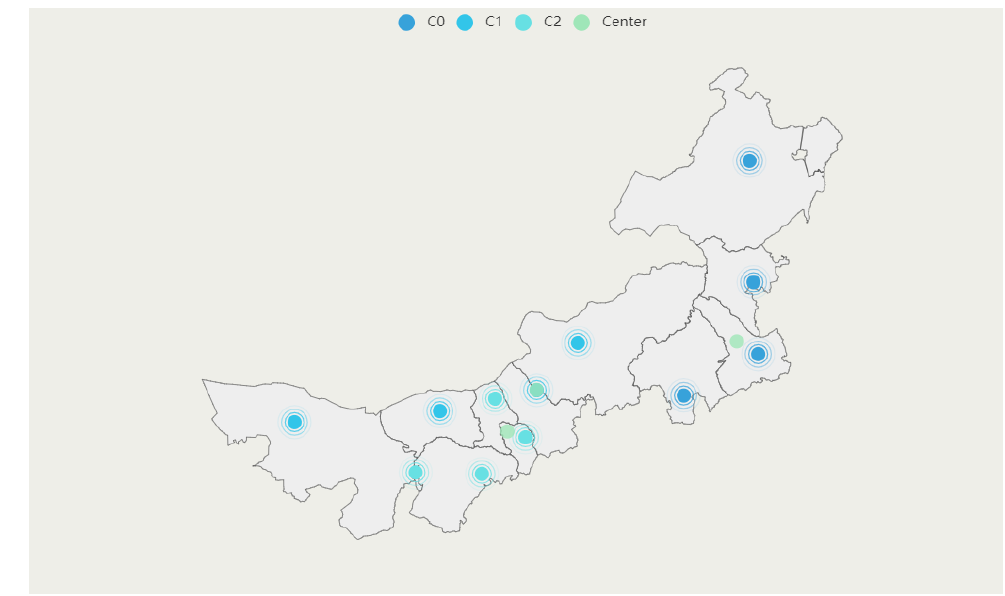
Figure 7. The location results for the I5ICM.